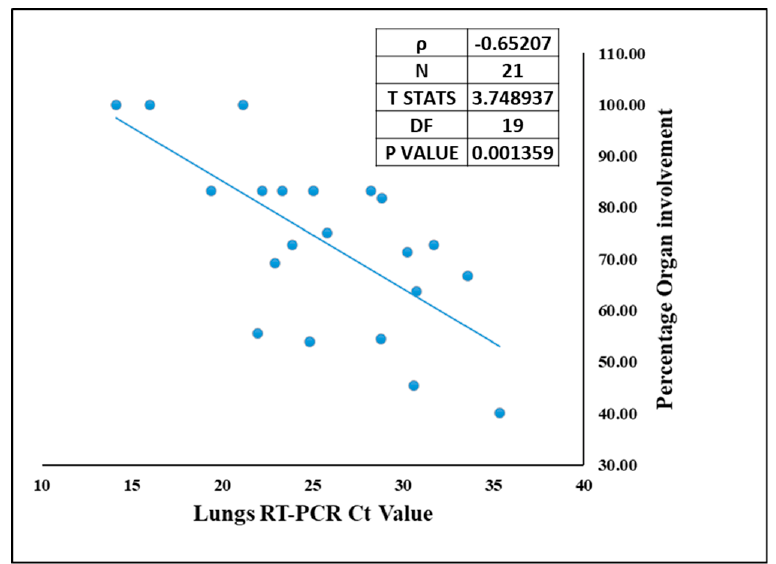
Figure 6. The correlation between SARS-CoV-2 viral RNA Ct value in the lungs and the organ involvement in each case.